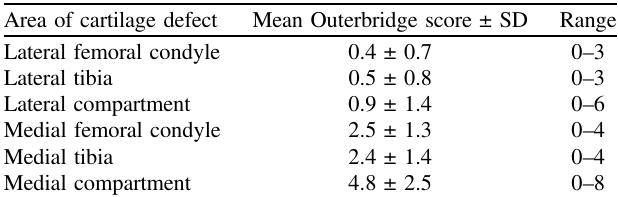
Table 3. Details on the mean Outerbridge score of the medial and lateral femorotibial